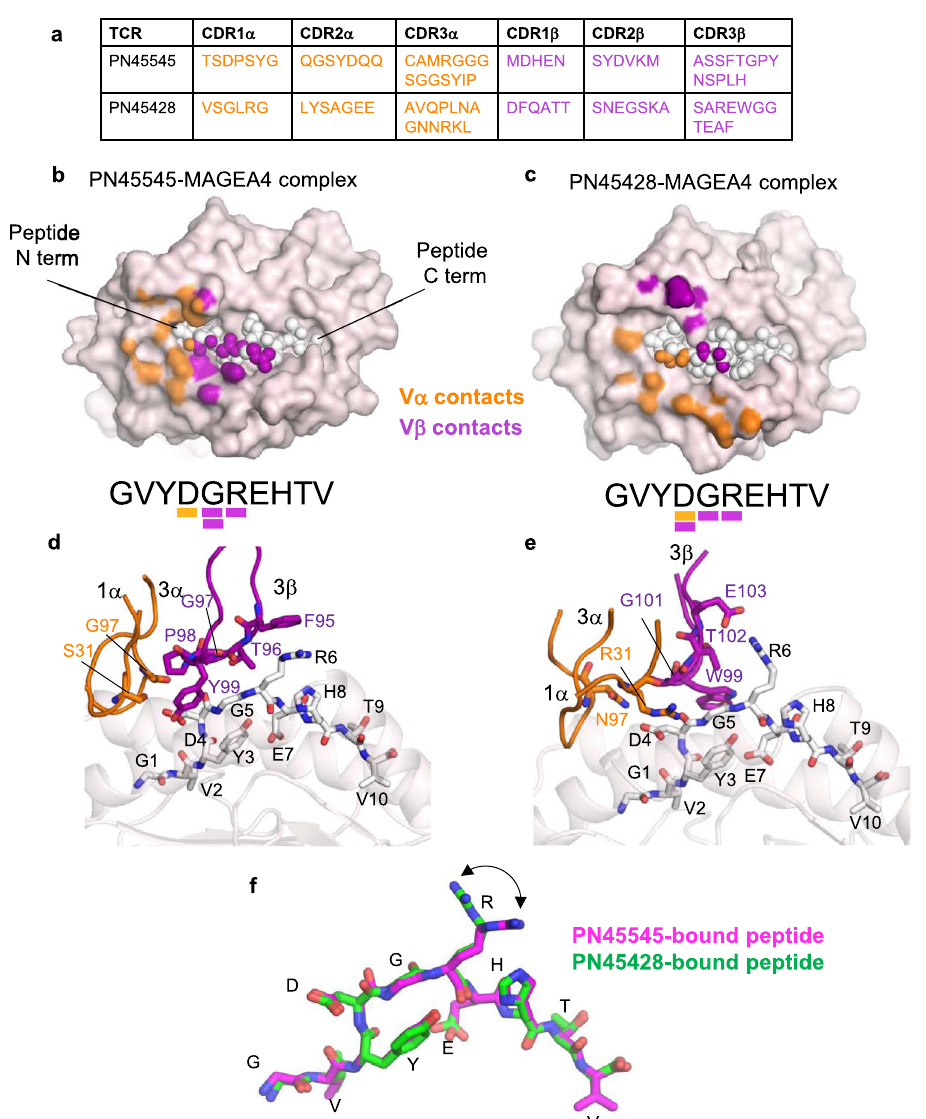
Fig. 3 | TCR-MAGEA4 pMHC interactions. a CDR sequences of PN45545 and PN45428 TCRs. b, c Top-down view of MAGEA4 pMHC complexes with TCR (PN45545 in b , PN45428 in c ), with HLA shown in surface representation and pep- tide shown as spheres. Atoms within 4.0Å of TCR V α (orange) or V β (purple) are colored. MAGEA4 peptide sequence is displayed underneath, with residues con- tacted by TCR underlined according to the same color scheme as above.